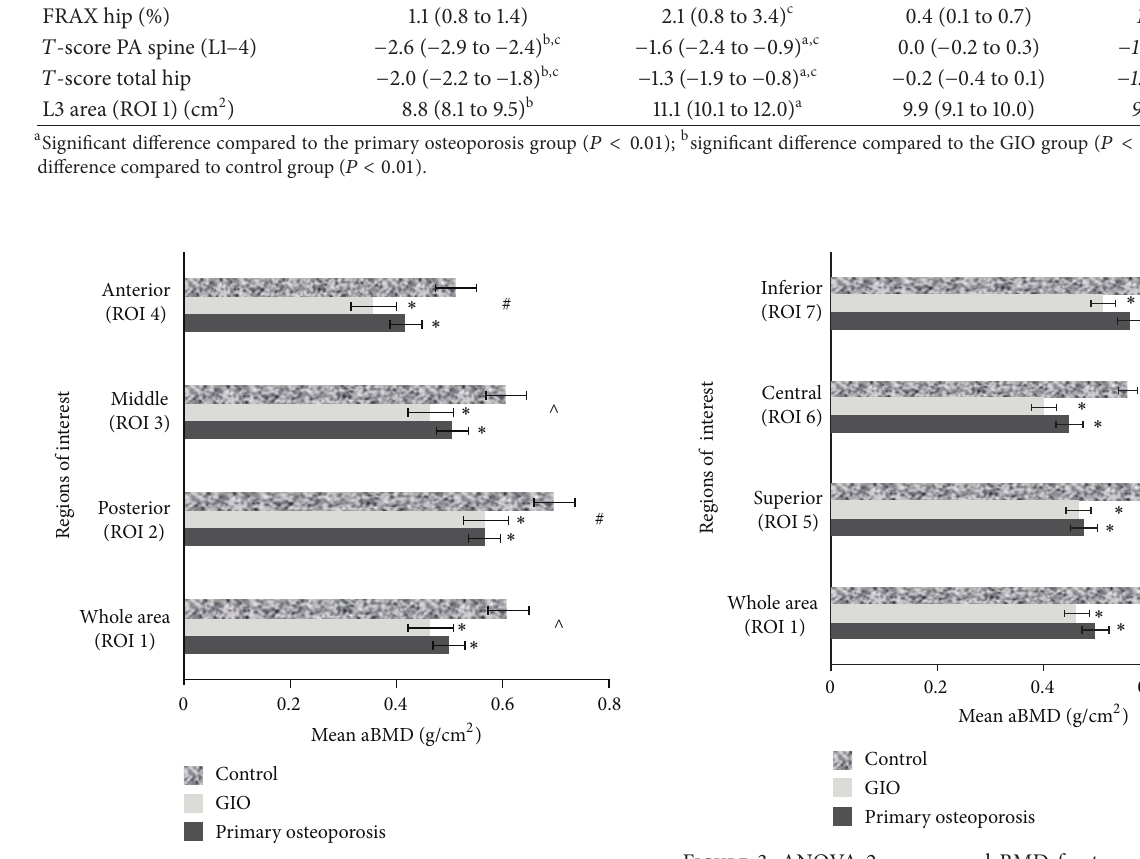
Figure 2: ANOVA 1, mean areal BMD for sagittal regions of interest between groups, adjusted for ROI 1 area. Error bars are SEM. ∗ Sig- nificantly different to controls ( 𝑃 < 0.0001 ). # Significantly different compared to all other ROIs. ∧ Significantly different to ROIs 2 and 4.